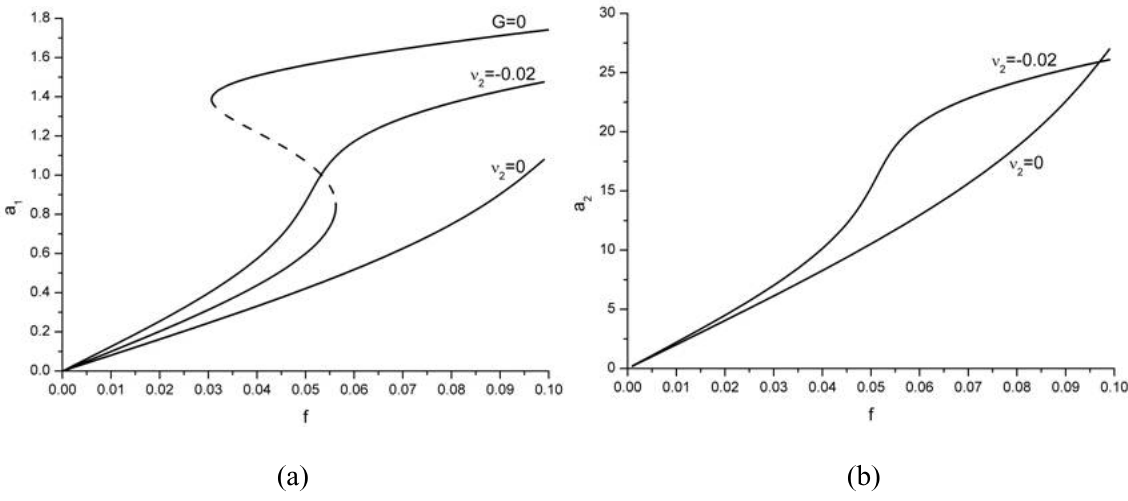
Fig. 13. Effect of detuning the absorber’s frequency on the force-response curves of (a) the plant and (b) the absorber when σ 1 = − 0 . 1 , G = 0 . 005 and ζ = 0 . 02